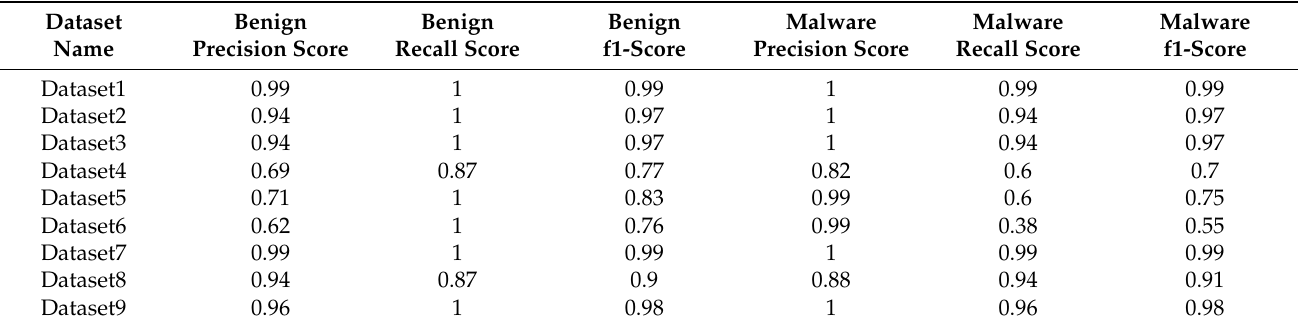
Table 12. Predication results when using the DT algorithm with minimum features.